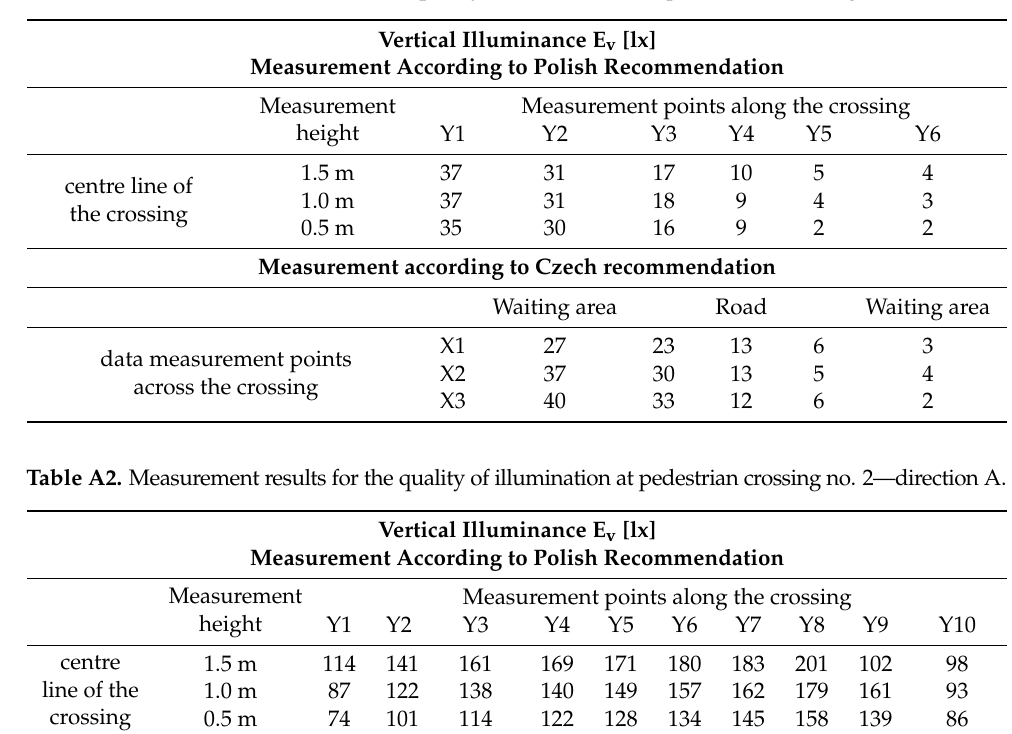
Table A1. Measurement results for the quality of illumination at pedestrian crossing no. 1.